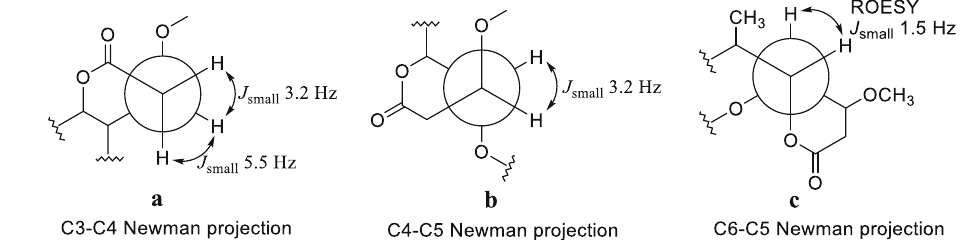
Fig. 3 Newman projection and key ROESY correlations in compound 1